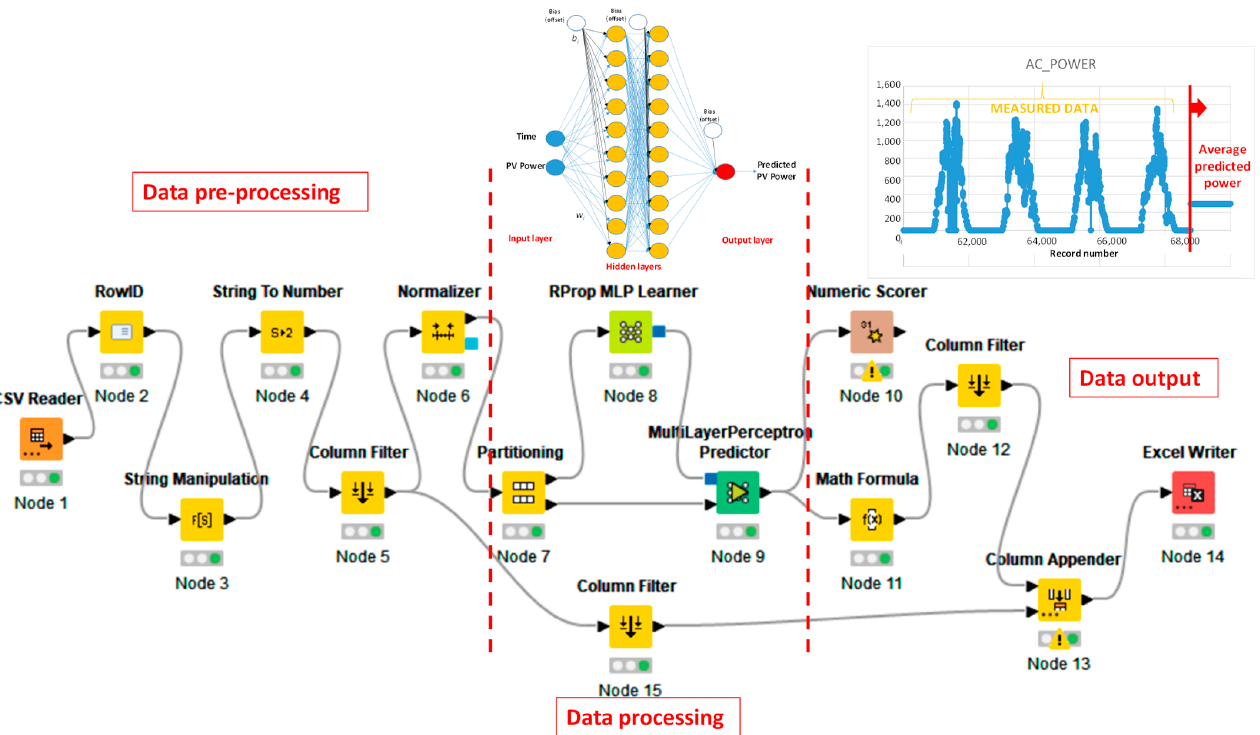
Figure A1. KNIME workflow implementing ANN-MLP algorithm to predict AC power generated by a PV plant. Insets: equivalent ANN-MLP network and predicted average AC power (expressed in kW) processing the dataset [105].